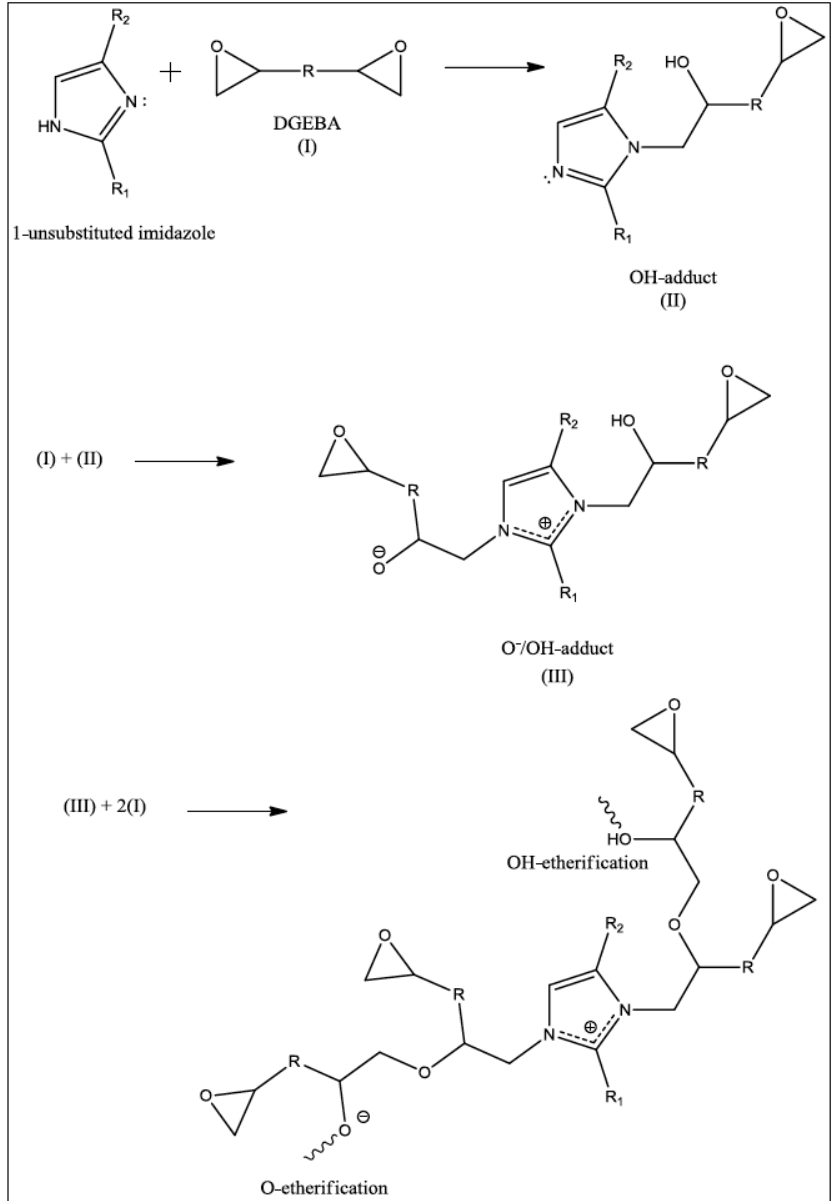
Figure 2. Mechanism of the reaction between 2-ethyl-4-methylimidazole and diglyidyl ether of bisphenol A (DGEBA) as proposed by Heise and Martin (R = CH 2 OPhC(CH 3 ) 2 PhOCH 2 , R 1 , R 2 = alkyl groups) [22].